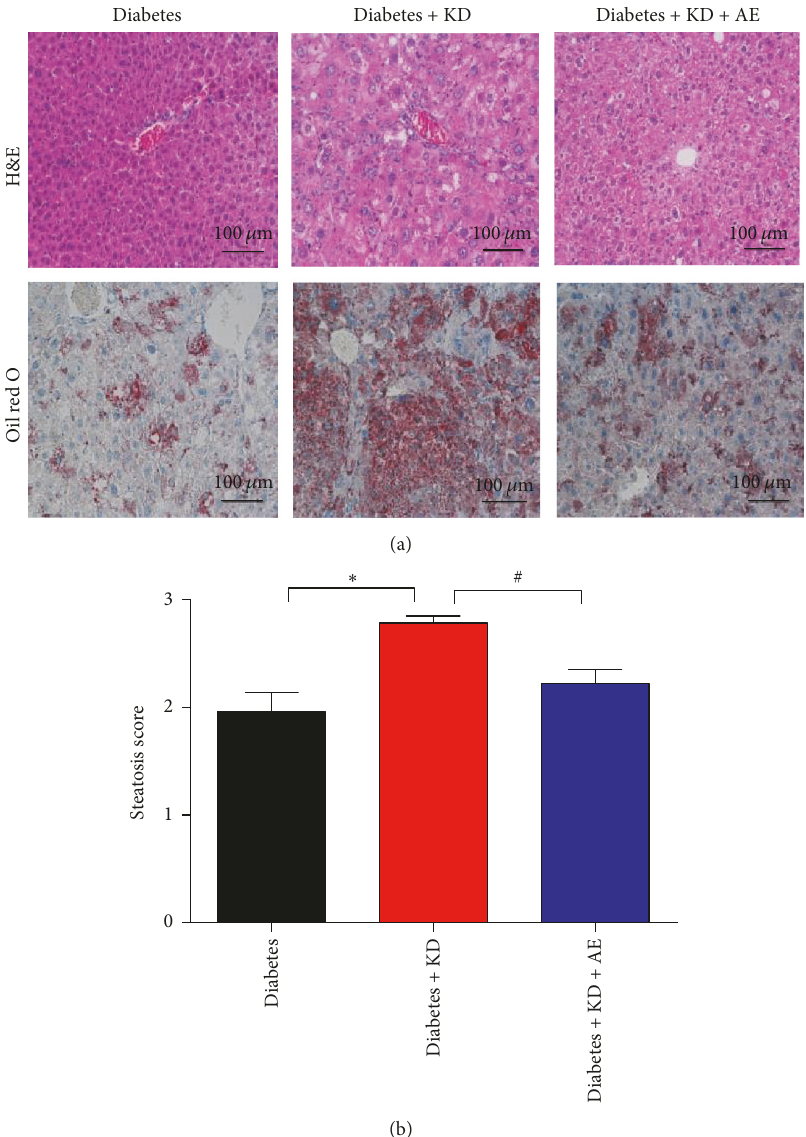
Figure 5: Aerobic exercise reduces ketogenic diet-induced hepatic steatosis in diabetic mice. (a) Representative images of hematoxylin and eosin and oil red staining of liver sections; (b) hepatic steatosis scores were evaluated based on oil red O staining. Original magnification, × 200. Scale bar, 100 𝜇 m. Data were presented as means ± SEM ( 𝑛 = 5 -6 per group) and statistical analysis was performed with 1-way ANOVA. ∗ 𝑃 < 0.05 versus diabetic group and # 𝑃 < 0.05 versus diabetes + KD